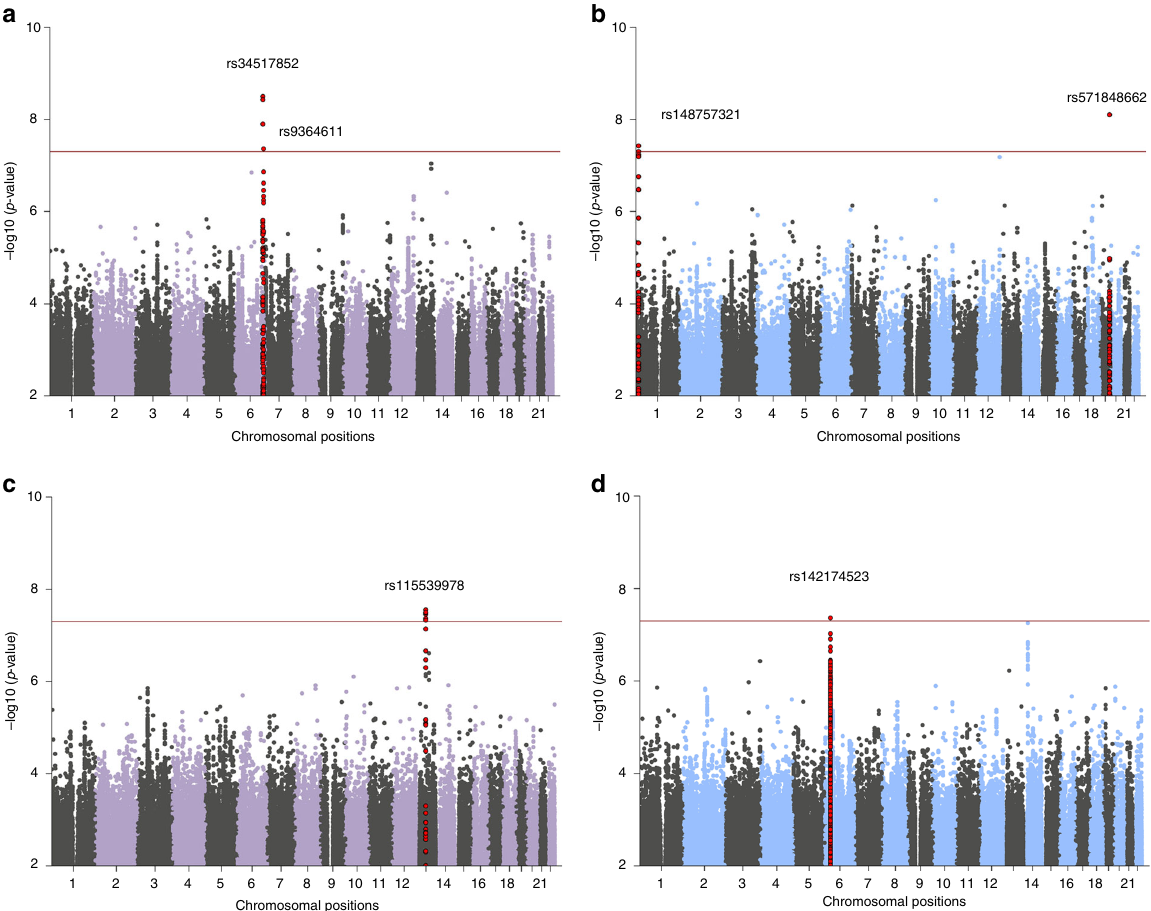
Fig. 1 Manhattan plots from meta-analyses of PTSD GWAS, showing the top variants in six independent genome-wide signi fi cant loci. Results are shown for subjects of European (EUA; a ) and African ancestry (AFA; c ), and for sex-strati fi ed analyses in EUA men ( b ) and AFA men ( d ), respectively. Sex- strati fi ed analyses for women were not signi fi cant (Supplementary Fig. 4). The red line represents genome-wide signi fi cance at P < 5 × 10 − 8 . Note: rs148757321 and rs142174523 do not remain signi fi cant after Bonferroni-adjustment for sex-strati fi ed analyses (at P < 1.67 × 10 − 8